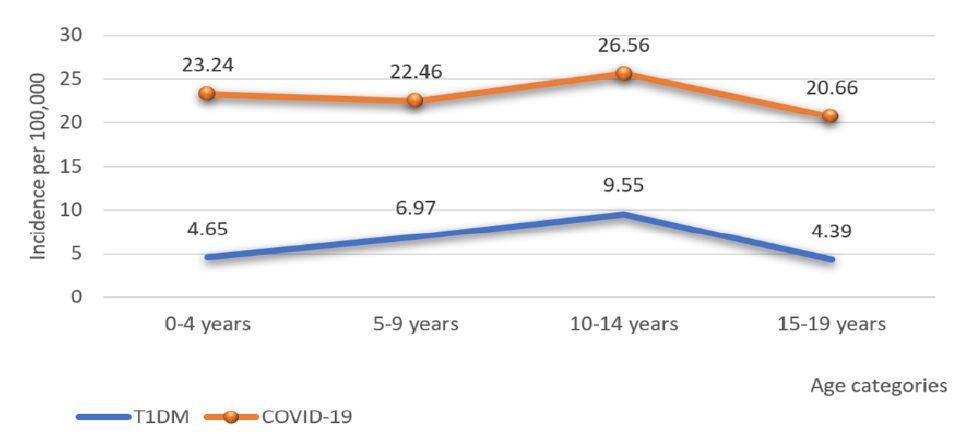
Figure 3. The incidence rate of T1DM and COVID-19 during 2020-2021 by age.